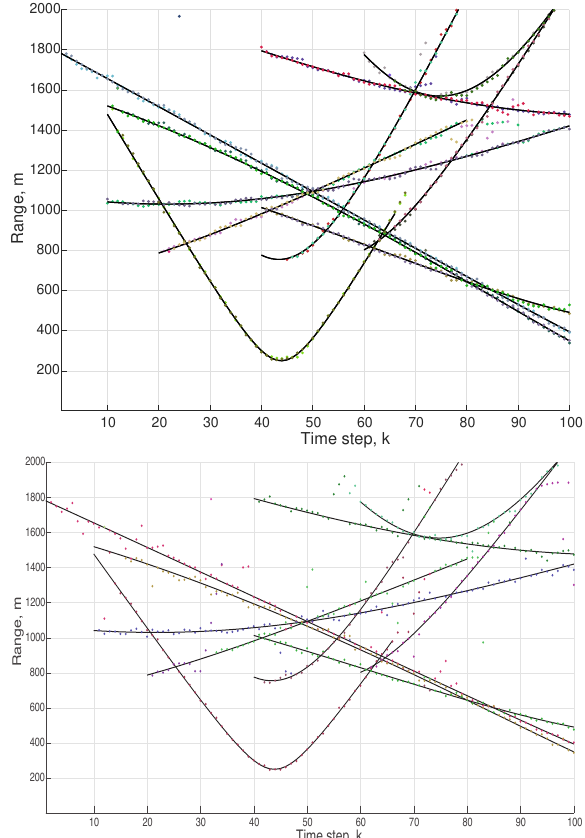
Figure 10. Range estimation using DPY-STP ( top ) and DDP-STP ( bottom ) in Experiment 4.